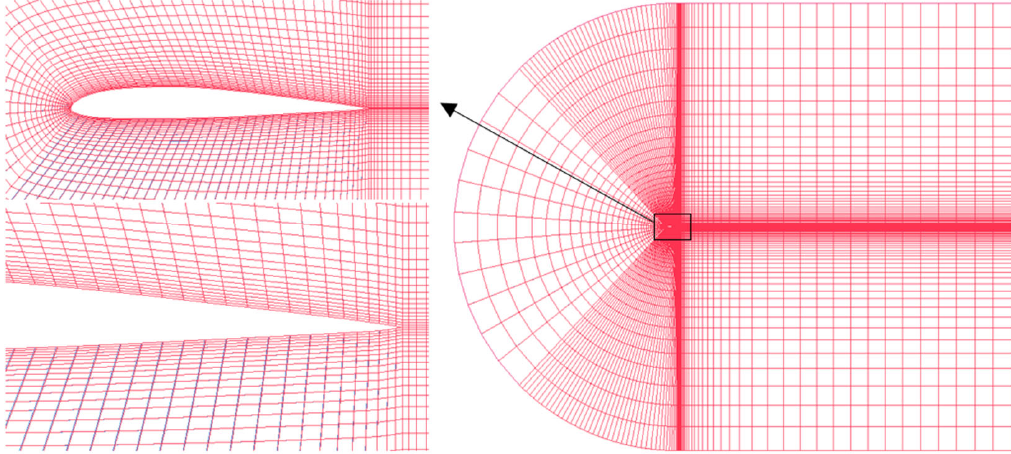
Figure 3. Illustration of the density of elements in the computational domain.